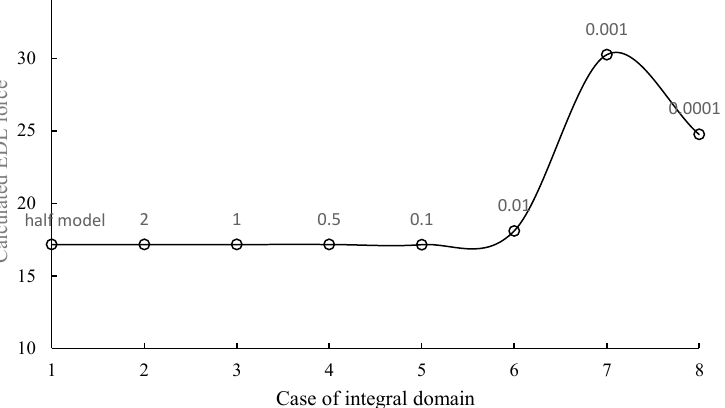
Figure 6. Calculated EDL forces for different chosen integral domain ( α = 60°, d = 1.0, and ϕ 0 = 10).